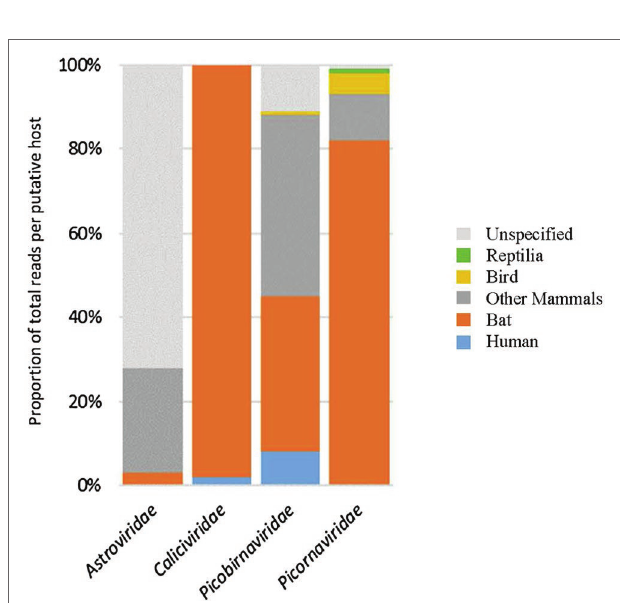
FIGURE 4 | Overview of the host diversity and reads identified as belonging to four viral families. For each family the number of reads was expressed in % referring to the host potentially infected. Only the most abundant assigned reads are presented here, regarding their capacity to infect humans (blue), bats (orange), birds (yellow), other mammals (dark grey), and unspecified hosts (light